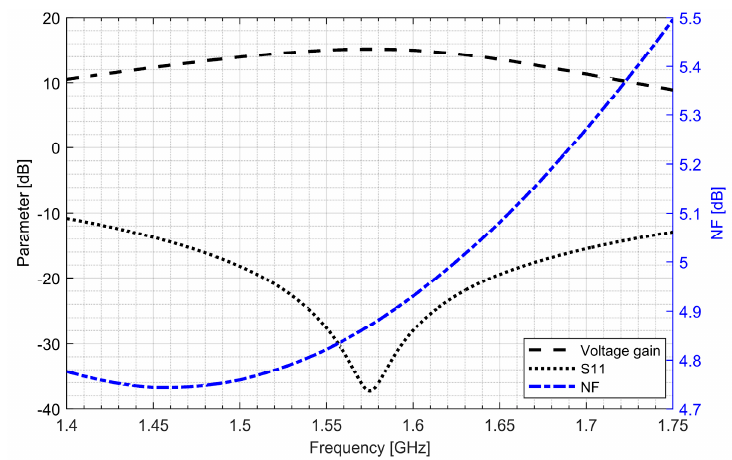
Figure 9. S11, voltage gain and noise figure characteristics of the L1/E1 band active balun.